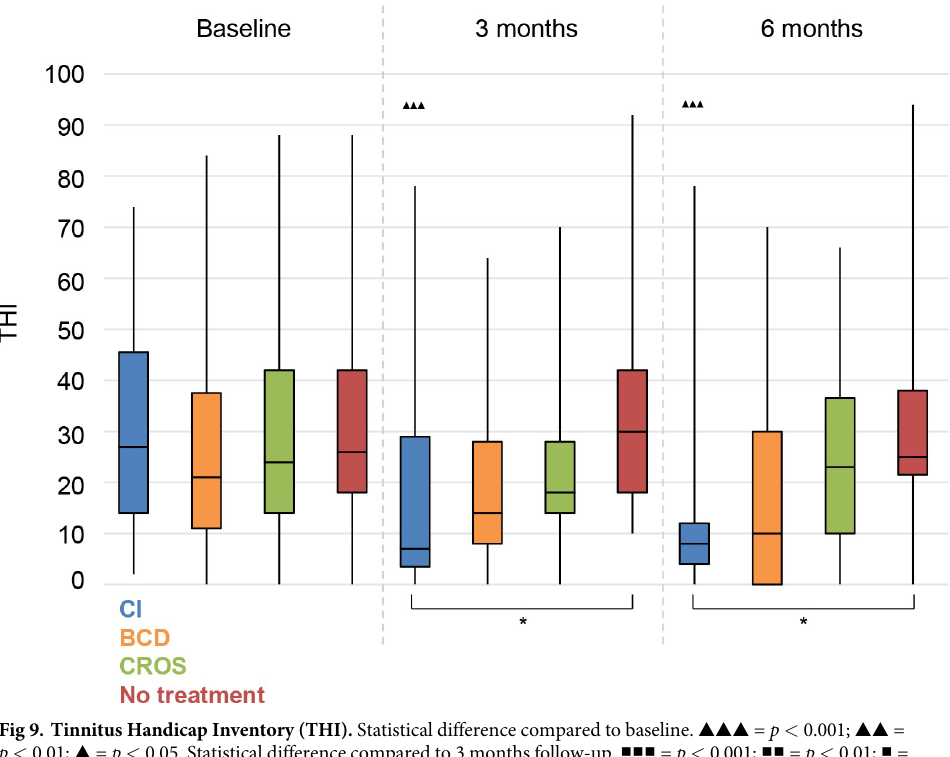
Fig 9. Tinnitus Handicap Inventory (THI). Statistical difference compared to baseline. ▲▲▲ = p < 0.001; ▲▲ = p < 0.01; ▲ = p < 0.05. Statistical difference compared to 3 months follow-up. ■■■ = p < 0.001; ■■ = p < 0.01; ■ = p < 0.05. Statistical difference between groups at same follow-up moment. ��� = p < 0.001; �� = p < 0.01; � = p <